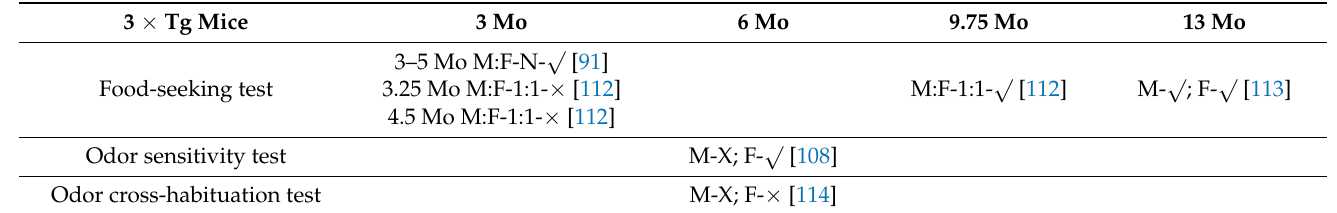
Table 5. Summary of data on the behavioral performance of the 3 × Tg mice; “3–5 Mo M:F-1:1-X” represented “age-sex-sex ratio-whether there is a difference”. Mo: month, M: male, F: female, N: √ unclear, × : no significant difference, : significant difference.